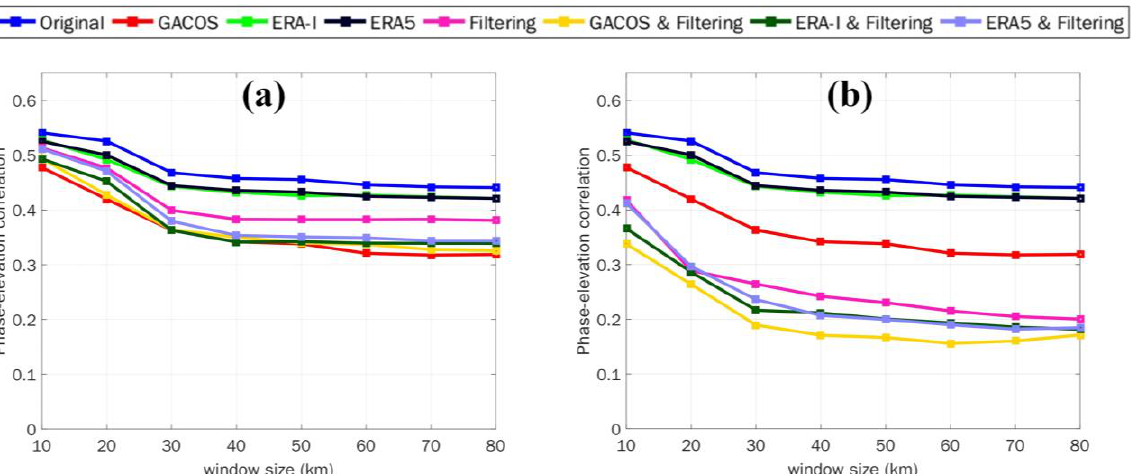
Figure 12. Phase-elevation rank correlation coefficient before and after tropospheric corrections, using the interferograms referenced to the acquisition date of 4 February 2017. ( a ) Results with the primary TOE retained. ( b ) Results after subtracting the primary TOE in the spatiotemporal filtering and the combined approaches.